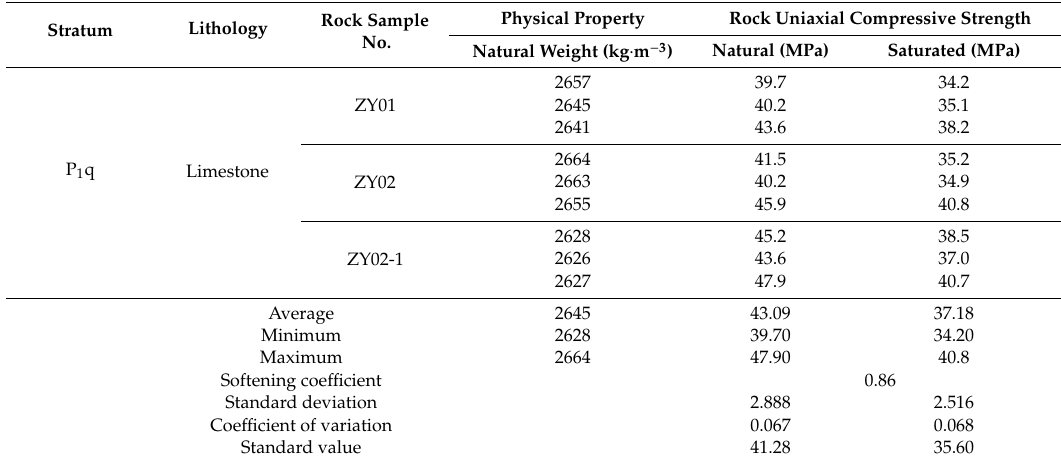
Table 1. Geotechnical, physical, and mechanical properties.